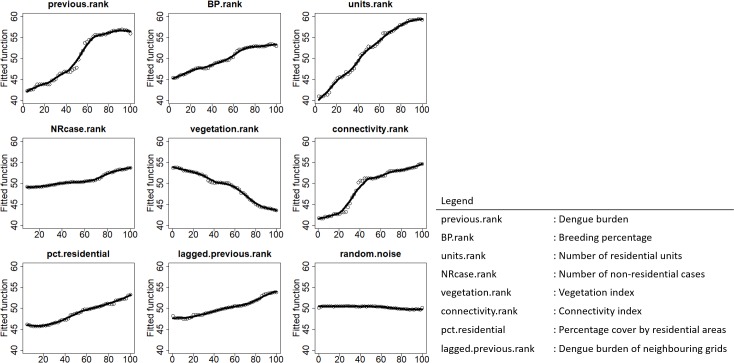
Partial dependence plot of the risk factors showing how dengue burden varies with one variable when all other variables are held constant at their average values.